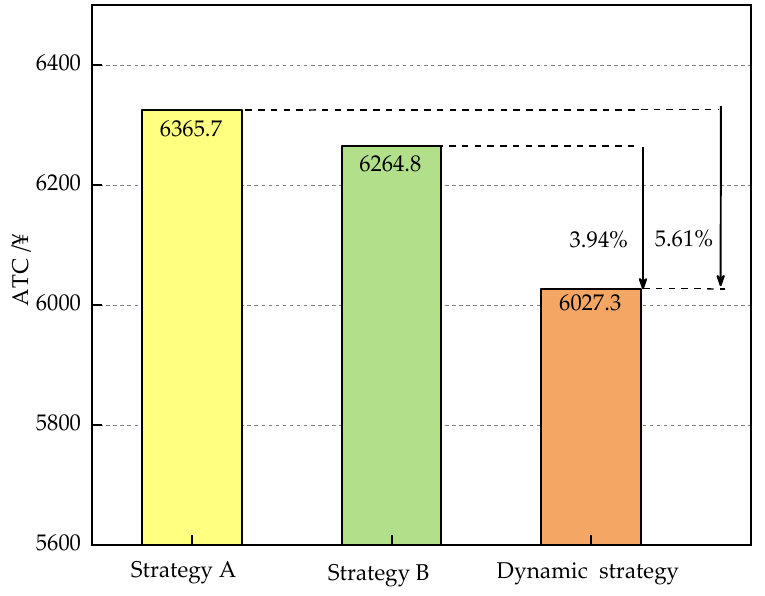
Figure 7. The net annual value of system costs in scenario 3. A detailed analysis was conducted on the optimal system operation in the heating season, transition season, and summer season in scenario 3. Analysis results show that, due to the battery discharge, the system’s power purchase under the dynamic operation strategy is less than those under the comparison strategies. Compared with the comparison strategy, due to the larger area of the collector and the smaller rated power of the heat pump under the dynamic operation strategy, the system consumes less electricity and can sell more electricity to the grid. Therefore, increase the economic benefits of the system and improve the economic performance of the system. In addition, the depth of discharge of the batteries under the dynamic operation strategy is smaller, which helps reduce the loss of the batteries and prolong the service life of the batteries. In Figure 8, the quantity of electricity is negative, which means the energy storage battery is discharged, and the system purchases electricity from the grid. E bba is the amount of remaining photovoltaic energy allocated to the battery. E bw is the amount of remaining photovoltaic energy allocated to the